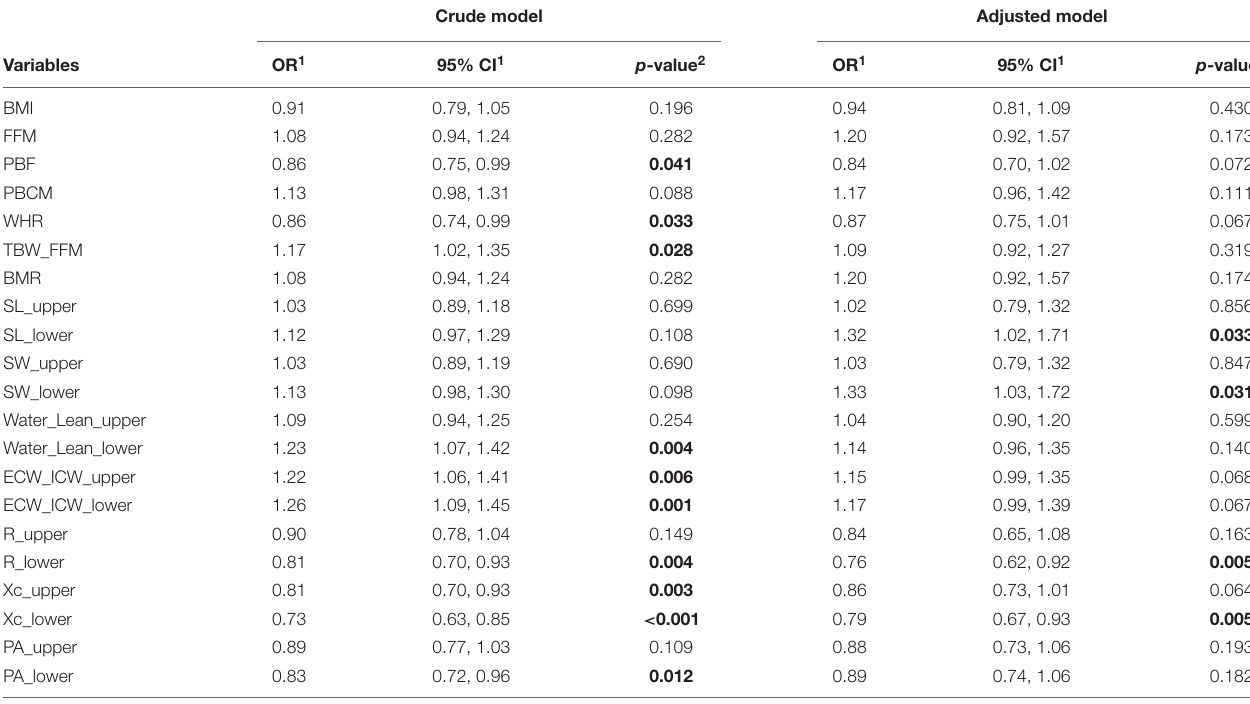
TABLE 3 | Estimated odds ratios and 95% confidence intervals derived from the two logistic regression models. Crude